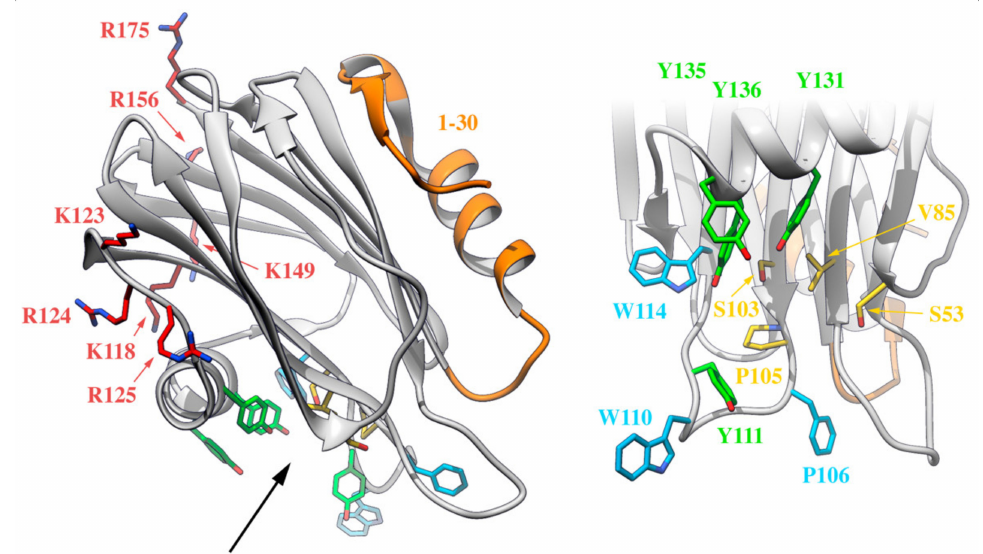
Figure 5. Four di ff erent functionally relevant regions can be distinguished in the water-soluble monomeric actinoporins, as depicted on this representation of the three-dimensional structure of StnII (PDB: 1GWY). The N-terminal stretch (in orange), an array of exposed and basic amino acids (in red and blue), a cluster of aromatic residues (in light blue, except the Tyr residues also belonging to the POC site, which appear in green), and the POC binding site (in yellow or green). Residues taking part in both the cluster of aromatic residues and the POC binding site are highlighted in green. The black arrow on the left panel indicates the point of view of the right panel, which is a close-up of the cluster of aromatic residues and the POC binding